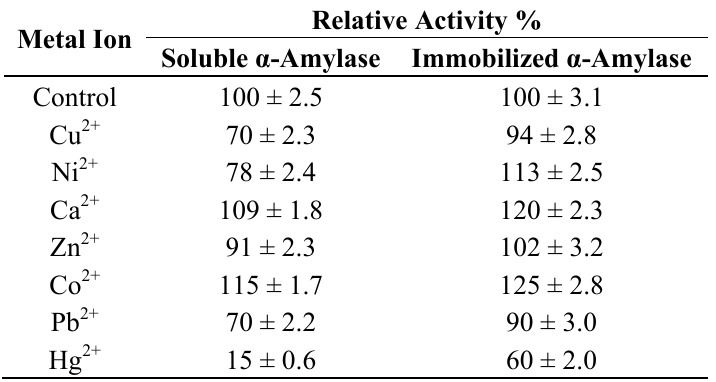
Table 3. The effect of metal ions on the soluble and immobilized α -amylases (1